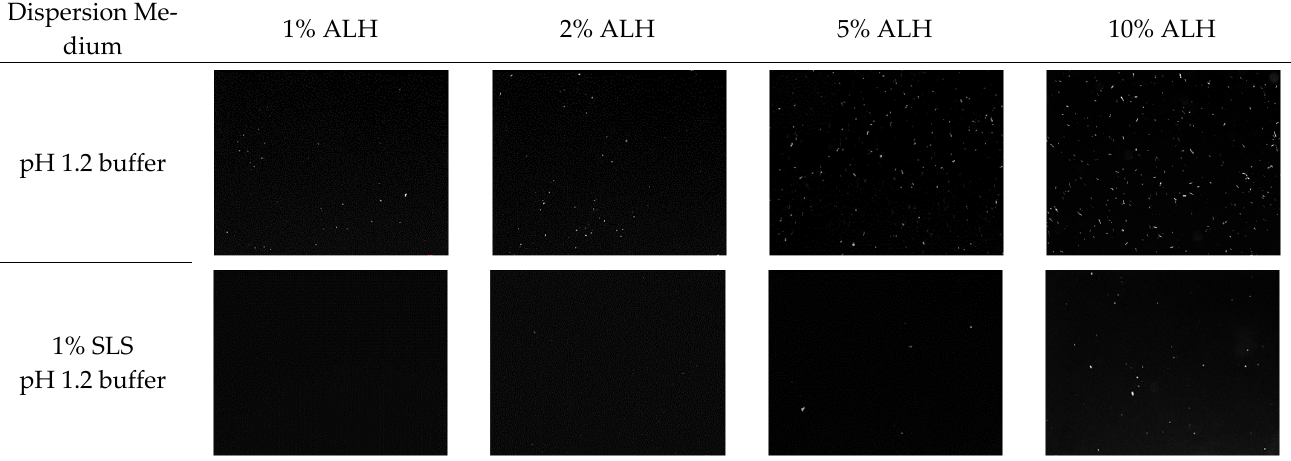
Figure 7. Optical microscope observation of ALH particles from the dispersion of ALH-loaded Su-SNEDDS (F6) in pH 1.2 buffer and 1% SLS pH 1.2 buffer.